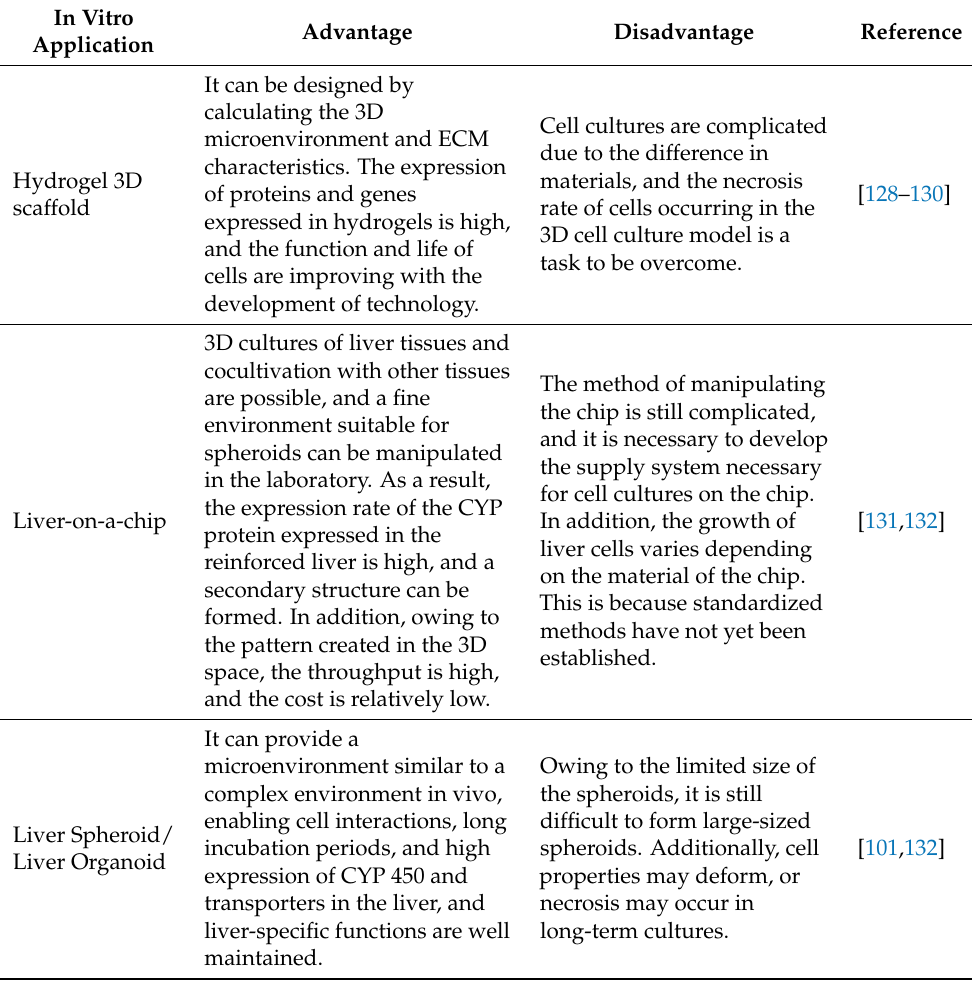
Table 3. Comprehensive comparison of hydrogel scaffolds, liver-on-chips, and liver